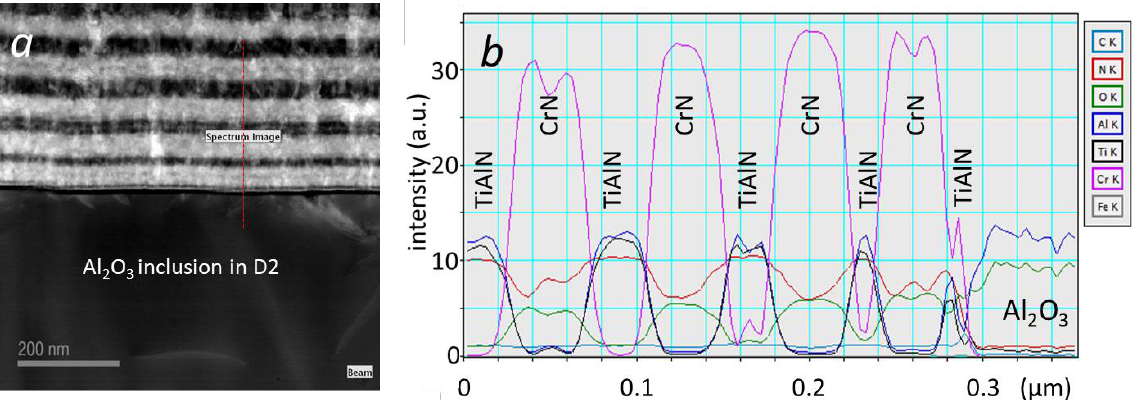
Figure 3. High-angle annular dark-field (HAADF) STEM image (Z-contrast image) of the NL-TiAlN/CrN hard coating sputter deposited on an Al 2 O 3 inclusion in the D2 tool steel substrate using the two-fold rotation ( a ) and EDS line scan along the dashed red line indicated in the STEM image ( b ).